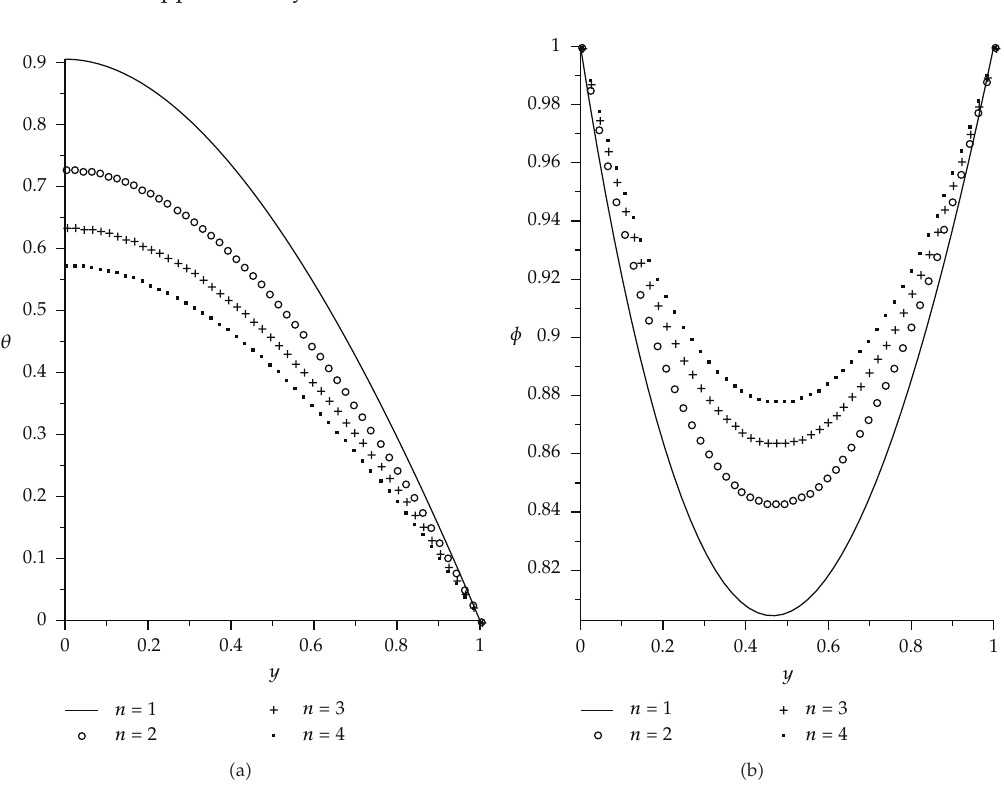
Figure 6: Temperature and oxygen concentration profiles for m (cid:8) 0 . 5 , λ (cid:8) β (cid:8) 1 , θ w (cid:8) 0 , ε (cid:8) 0 . 1.